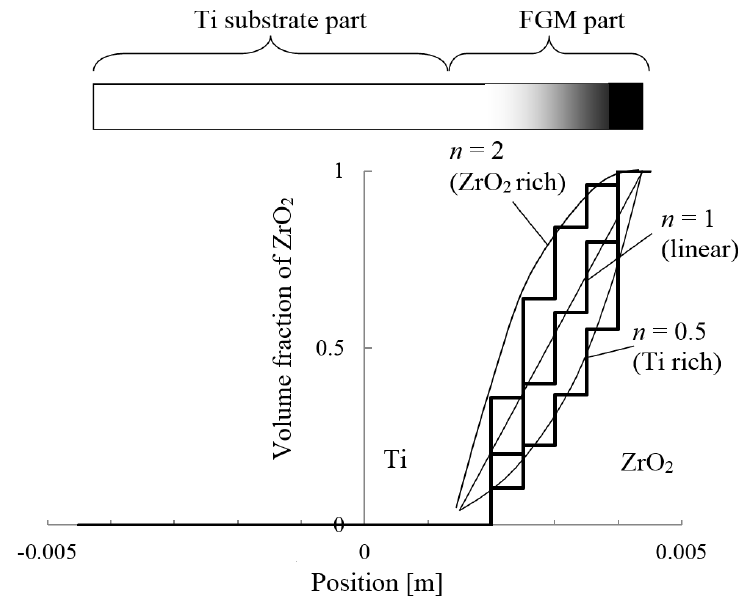
Figure 2. Compositional gradation patterns of FG